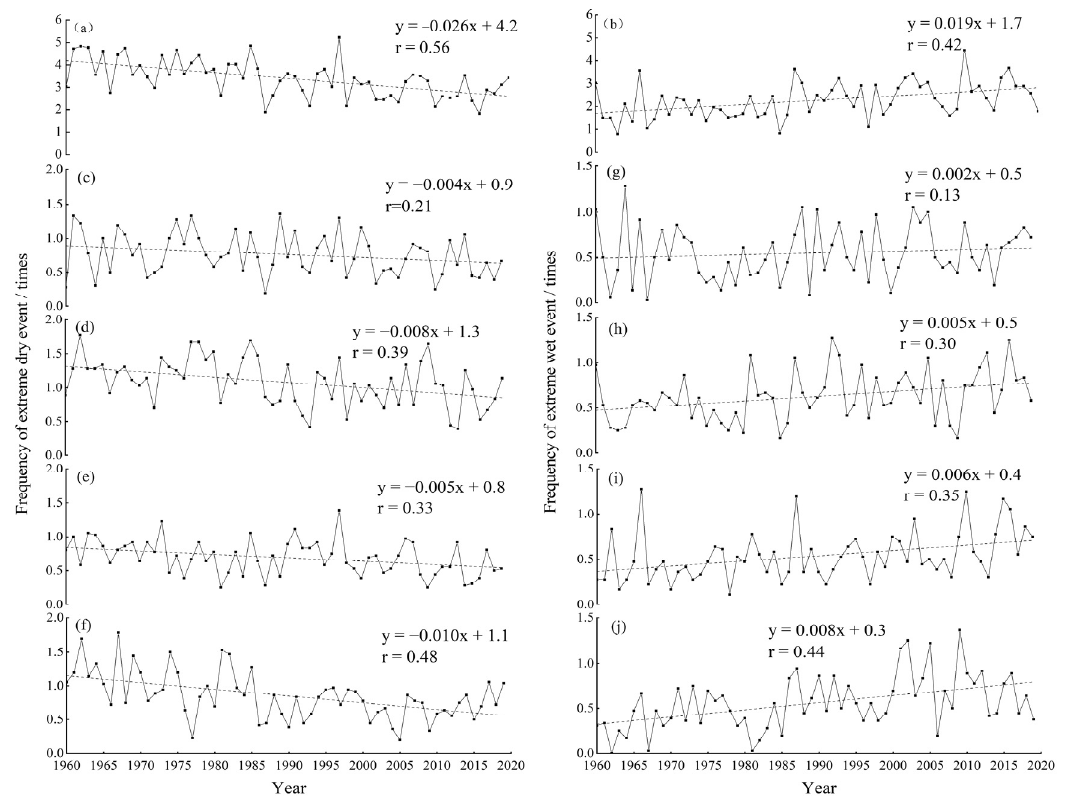
Figure 2. Trend in extreme dry/wet events by year ( a , b ), spring ( c , g ), summer ( d , h ), autumn ( e , i ) and winter ( f , j ) in Xinjiang from 1960 to 2020.